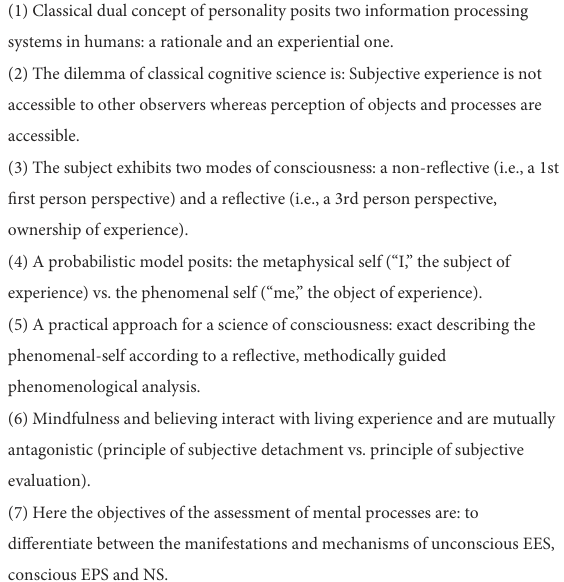
TABLE 1 A change of personality concept to integrate the subject’s experiential mode of information